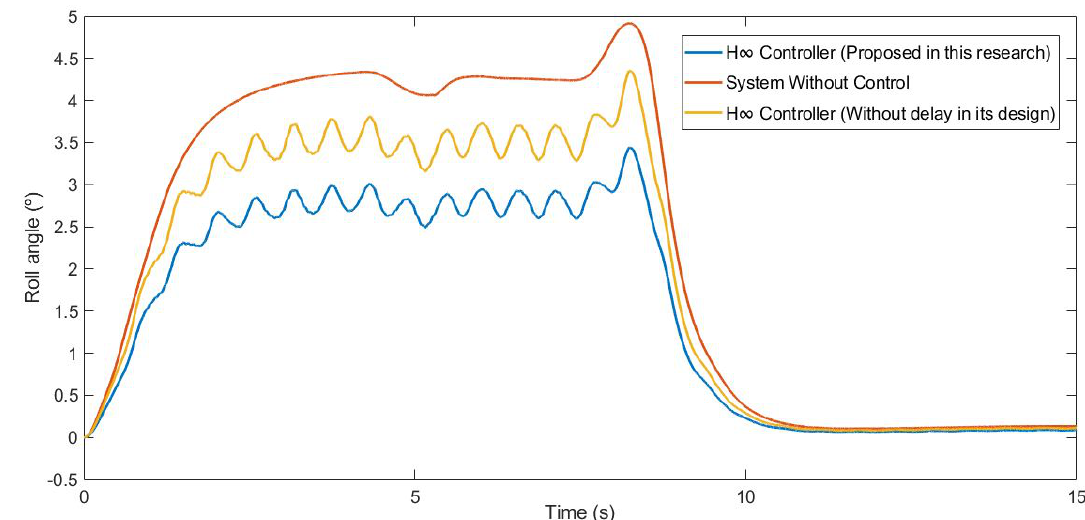
Figure 11. Roll angle for test 1: Roundabout at 30 km/h.